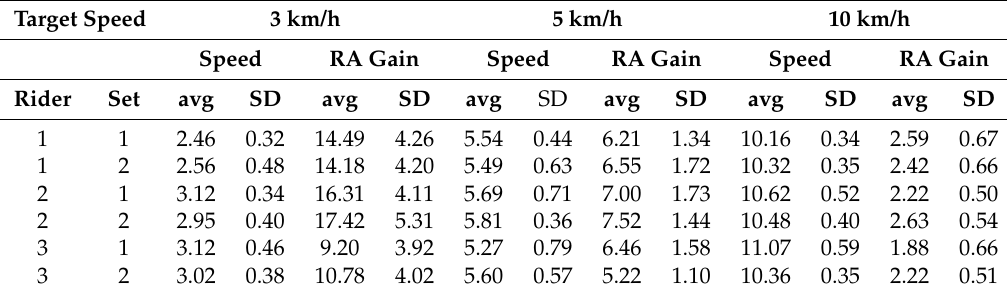
Table 3. Averages and standard deviations of motorcycle speed (v) and roll angle gain